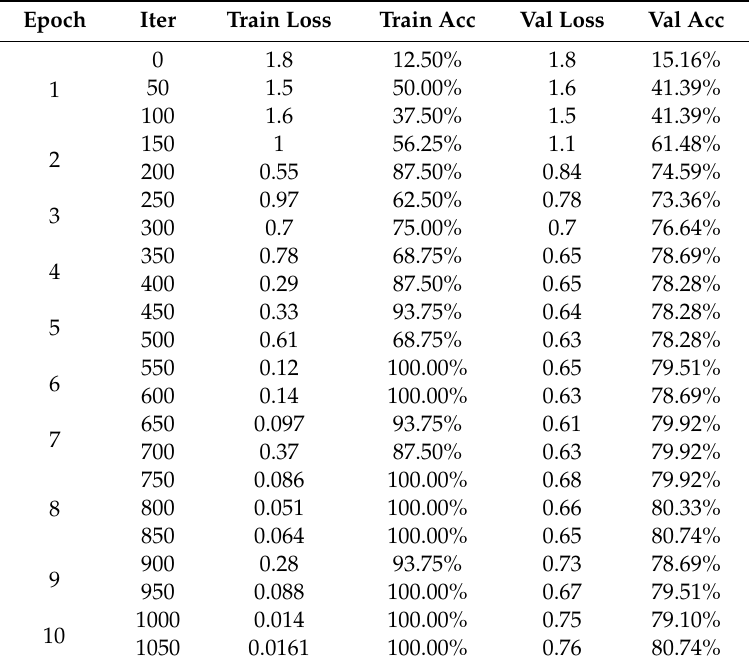
Table 2. Training result.